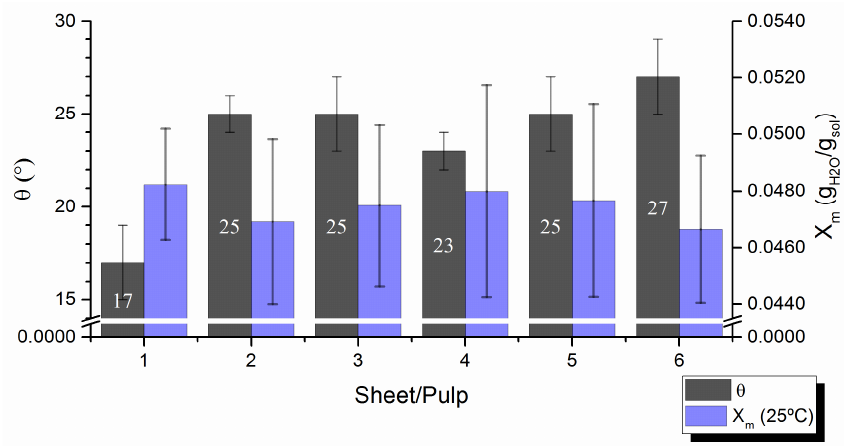
Figure 5. Monolayer capacity ( X m ) of 1 – 6 pulps at 25 °C and the average contact angles of corresponding handsheets.